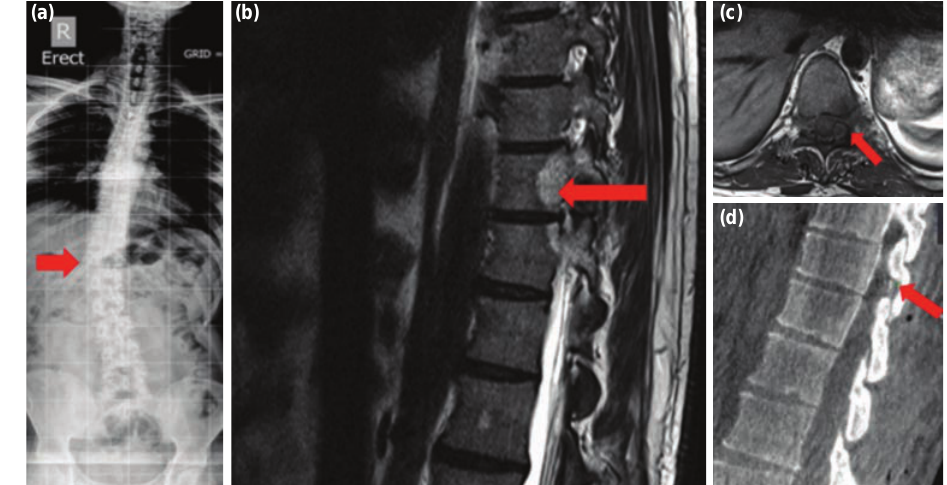
(a) Radiograph full length anteroposterior view showing the scoliosis with convexity to the right. (b) A well-defined lytic lesion Fig. 1: seen on MRI sagittal cut involving the superior articular process of the D11 vertebra. (c) MRI axial cut showing lesion superior articular process of D11. (d) Intra-operative image showing adequacy of extirpation using the navigation probe in sagittal image.